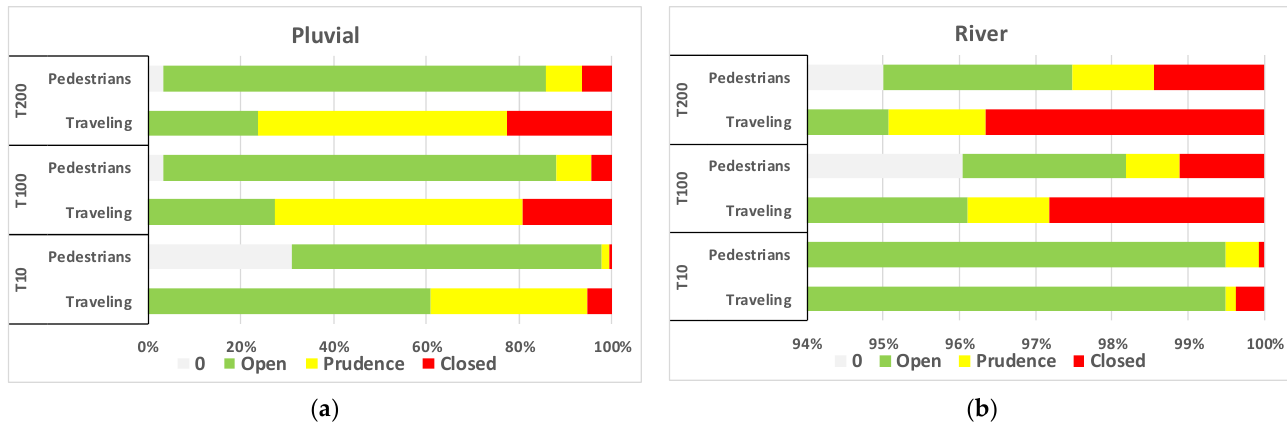
Figure 4. Distribution of road accessibility for vehicles and pedestrian across different T: ( a ) pluvial flood; ( b ) river flood.